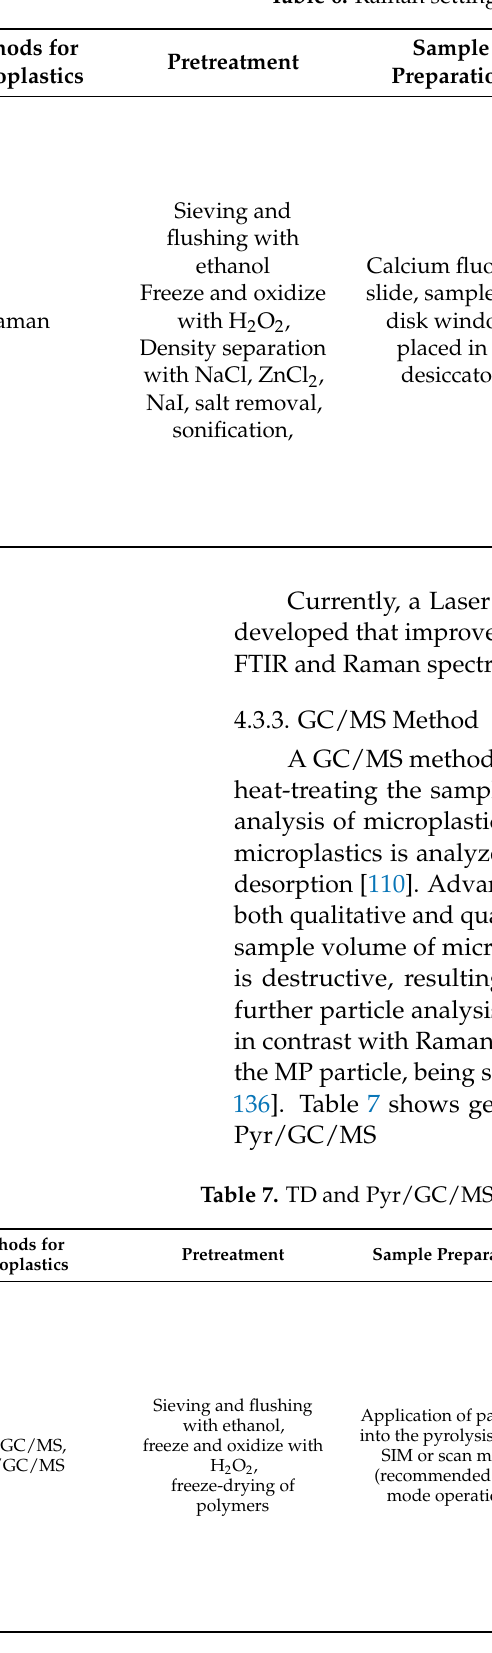
Table 6. Raman setting condition for microplastic analysis.